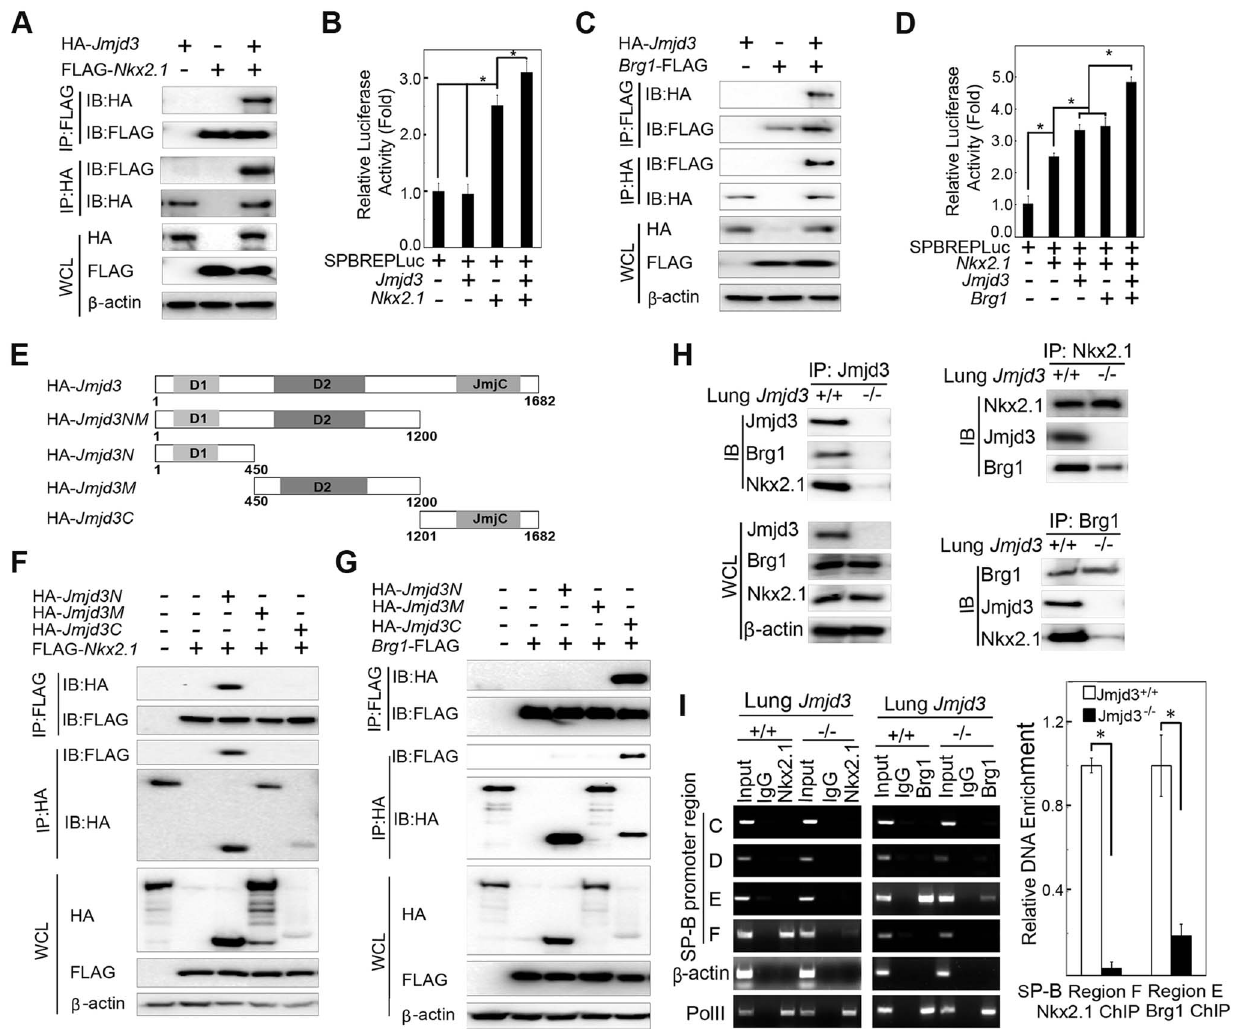
Figure 6. Jmjd3 coregulates SP-B expression with Nkx2.1 and Brg1. ( A ) The interaction between Jmjd3 and Nkx2.1 was evaluated by coimmunoprecipitation (CoIP) analysis of 293T cells expressing HA-tagged Jmjd3 and FLAG-tagged Nkx2.1 . ( B ) A cell-based luciferase assay was used to evaluate SP-B promoter activity in 293T cells cotransfected with Nkx2.1 , Jmjd3 , and mouse SP-B promoter-linked episomal luciferase vector (containing Nkx2.1 binding sites). ( C ) The interaction between Jmjd3 and Brg1 was determined by CoIP analysis of 293T cells expressing HA-tagged Jmjd3 and FLAG-tagged Brg1 . ( D ) Cell-based luciferase assay was used to evaluate SP-B promoter activity in 293T cells cotransfected with Nkx2.1 , Jmjd3 , Brg1 , and mouse SP-B promoter-linked episomal luciferase vector. * P , 0.05 (Student’s t test). ( E ) Generation of Jmjd3 deletion constructs. Numbers represent the corresponding amino acid residue position in the Jmjd3 coding region. ( F ) CoIP analysis of the interaction between Nkx2.1 and HA-tagged truncated Jmjd3 proteins. ( G ) CoIP analysis of the interaction between Brg1 and truncated Jmjd3 proteins. ( H ) CoIP analysis of the interaction among endogenous Nkx2.1, Brg1, and Jmjd3 in WT and Jmjd3 -deficient lung tissues. ( I ) ChIP-PCR and ChIP-qPCR analysis of Nkx2.1 and Brg1 binding to SP-B promoter regions in WT and Jmjd3 -deficient lung tissues. * P , 0.05 (Student’s t